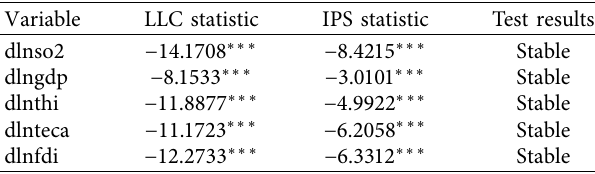
Table 3: PVAR lag-order test results. Table 2: Variable stability